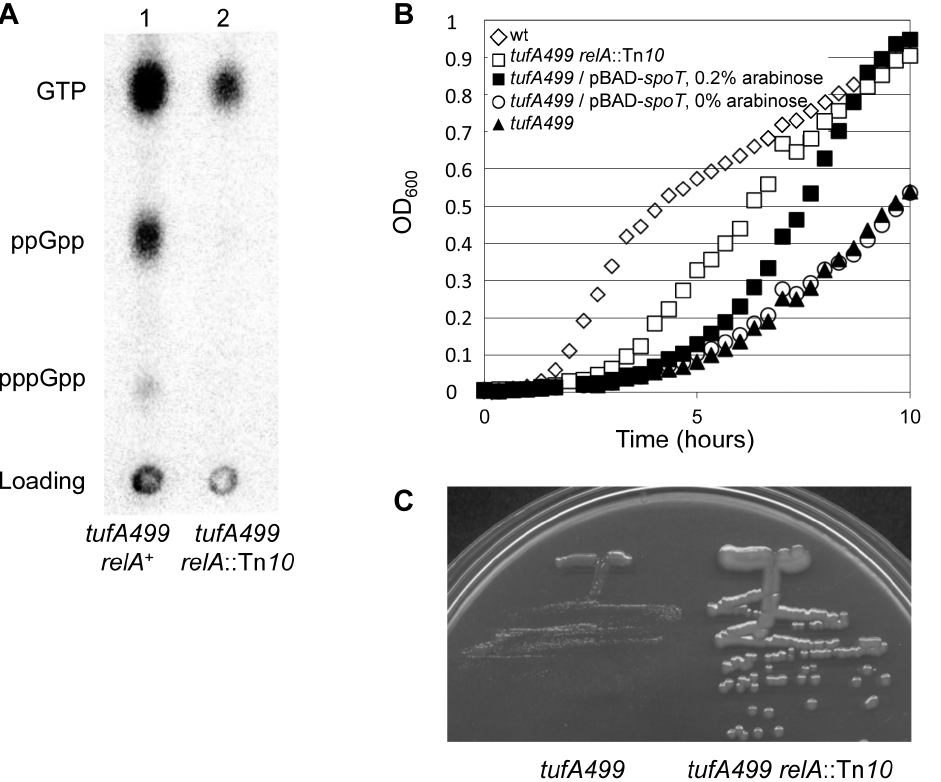
Figure 3. Inactivation of relA reduces ppGpp level and increases mutant growth rate. (A) Reduction in ppGpp levels associated with inactivation of relA . Thin layer chromatography of guanine nucleotides isolated from strains with the tufA499 allele. Lane 1: TH7509 ( tufA499 ). Lane 2: TH7975 ( tufA499 , relA21 ::Tn 10 ). The positions of ppGpp, pppGpp and GTP are indicated. (B) Growth curves of TH7507 ( tufA + ), TH7975 ( tufA499 relA ::Tn 10 ), TH7964 ( tufA499 /pBAD- spoT ) grown with 0.2% arabinose to cause overexpression of spoT or 0% arabinose as a control, and TH7509 ( tufA499 ), all grown in LB (Bioscreen). Growth curves are from a single, representative, experiment. (C) Strains grown on an LA plate for 18 h at 37 u C. Left panel: TH7509 ( tufA499 ); Right panel: TH7975 ( tufA499 relA21 ::Tn 10 ).